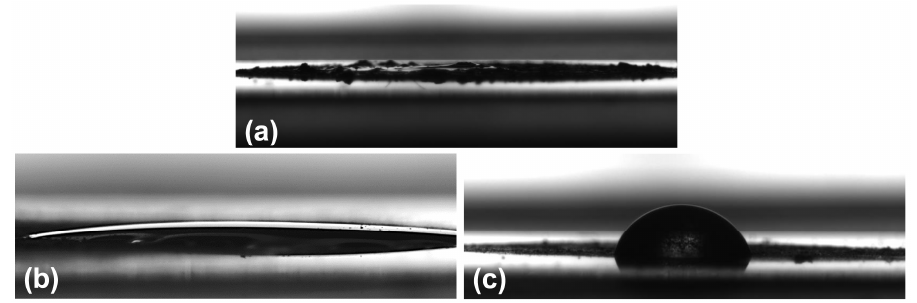
Figure 8. Water contact angle measurement results for ( a ) TiO 2 NPs, ( b ) TiO 2 /SiO 2 , and ( c ) TiO 2